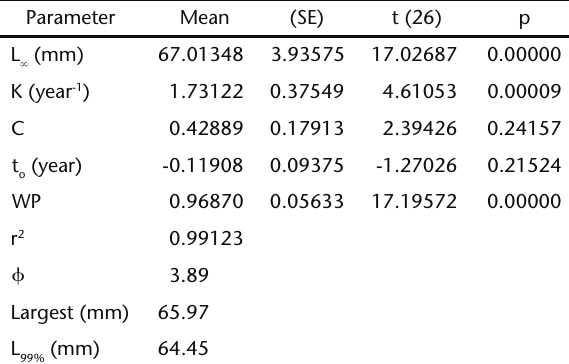
Table II. Tagelus plebeius . Growth parameters estimated by the seasonal modified version of the von Bertalanffy growth function. (L (cid:2) ) Asymptotic length; (K) curvature parameter; (C) constant for the amplitude of seasonal oscillation of growth; (t at length 0; (WP) winter-point: point of lowest growth rate in the year; (r 2 ) determination coefficient; ( (cid:3) ) standard growth index; (L ) length representing 99% of the population and used to 99% estimate life span.